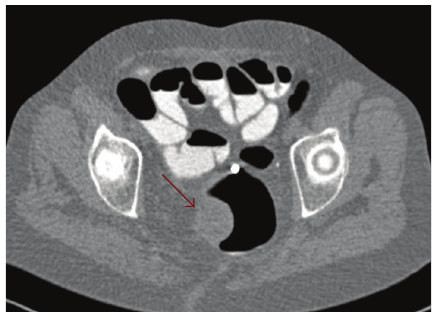
Figure 2: MDCT scan. Mass with slightly eccentric hypodense area and early enhancement after contrast medium intravenous injection.